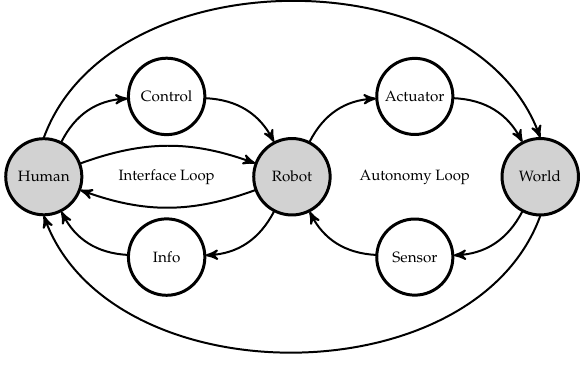
Figure 3. Co-located robot operation (inspired by the remote robot operation by Crandall et al. [3]).